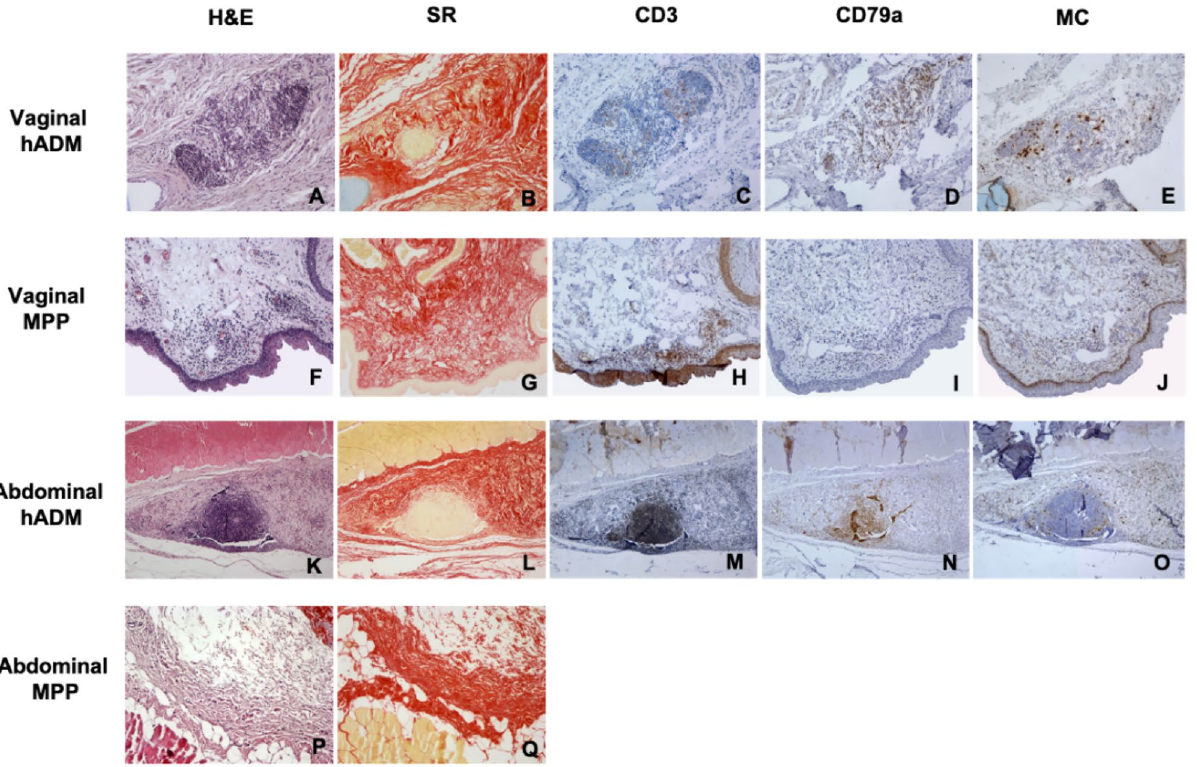
Figure 2. Representative histology and immunohistochemical staining of serial vaginal ( A – J ) and abdominal ( K – Q ) sections: Hematoxylin–Eosin ( H & E ), ( A , F , K , P ), Sirius Red (SR), ( B , G , L , Q ), T lymphocytes (CD3),